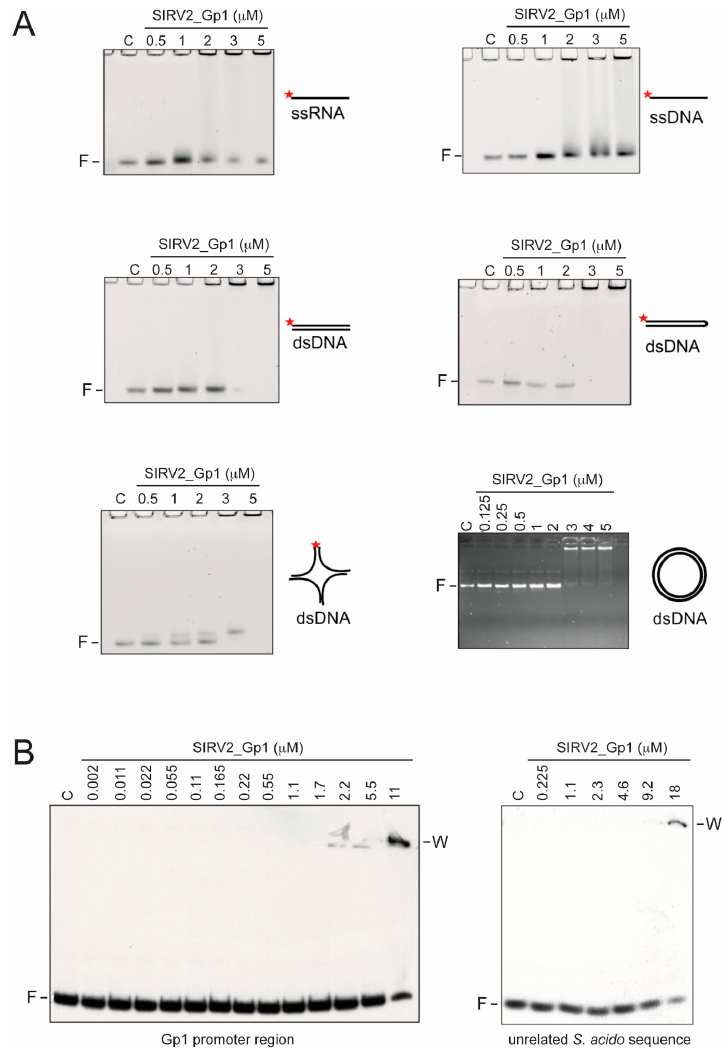
Figure 1. Nucleic ‐ acid binding assays of SIRV2_Gp1 protein. ( A ) Fluorescence imaging of nucleo ‐ protein adduct formation with SIRV2_Gp1 as seen after native gel electrophoresis of SIRV2_Gp1 with single ‐ stranded (ss) RNA, ssDNA, double ‐ stranded (ds) DNA, hairpin DNA and Holliday junction DNA, as indicated. The electrophoretic mobility shift assay (EMSA) experiment with plasmid DNA (right bottom panel) was not performed with fluorescently labeled DNA, but instead by ultraviolet (UV) imaging of an ethidium bromide ‐ stained 1% agarose gel. Each substrate was incubated with different concentrations of the protein indicated in μ M prior to being subjected to native gel electrophoresis. C indicates the control reaction without any protein. ( B ) EMSA of different concentrations of SIRV2_Gp1 with short 32 P ‐ labeled probes representing the Gp1 promoter sequence and an unrelated promoter sequence of Sulfolobus acidocaldarius , as indicated. Binding reactions were performed in presence of unlabeled competitor DNA. F, free probe. W, wells.